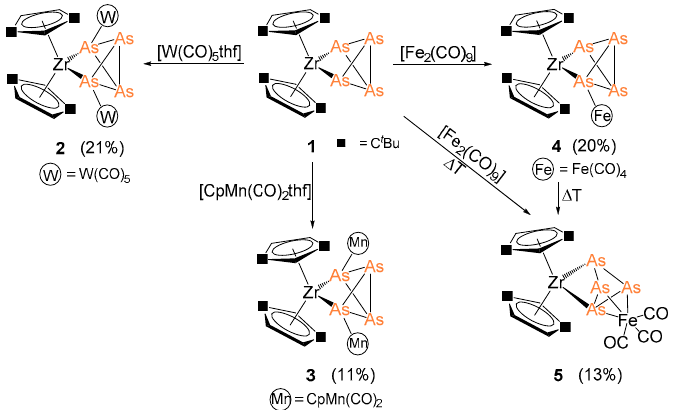
Scheme 2. Overview of the reactions of [Cp’’ 2 Zr( η 1:1 -As 4 )] ( 1 ) with Lewis-acidic transition metal compounds.